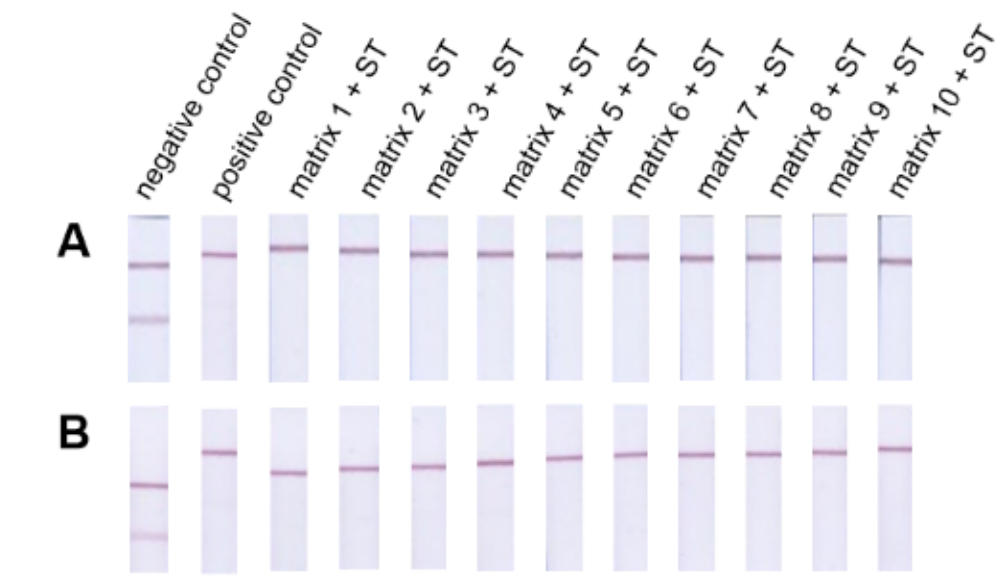
Figure 4. Spiked real supplements with ST (diluted 100×). The method was tested in both formats, i.e., indirect (panel ( A )) and direct format (panel ( B )).